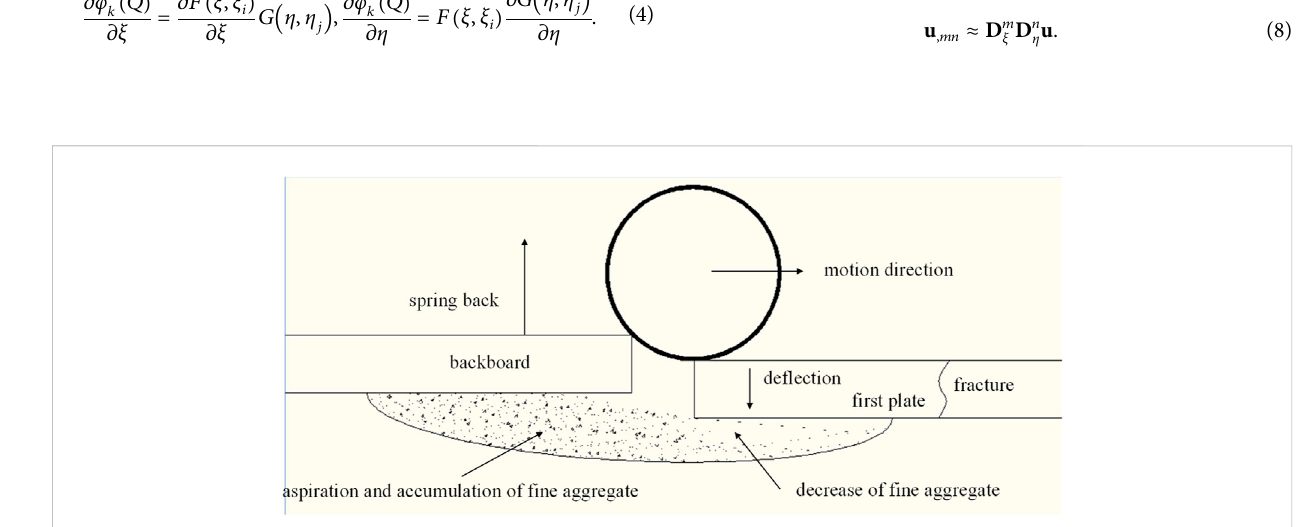
FIGURE 3 Disengaging of the cement concrete pavement plate.